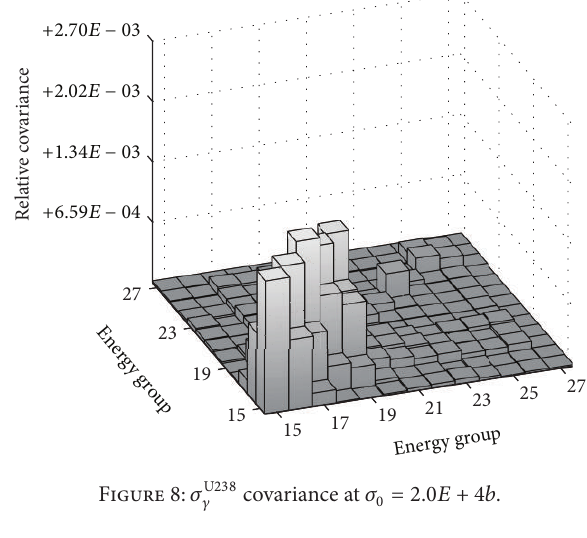
Figure 5: Resonance group Δ𝜎/𝜎 versus dilution relative to infinite dilution of 𝜎 U 238 𝛾 using TMC.